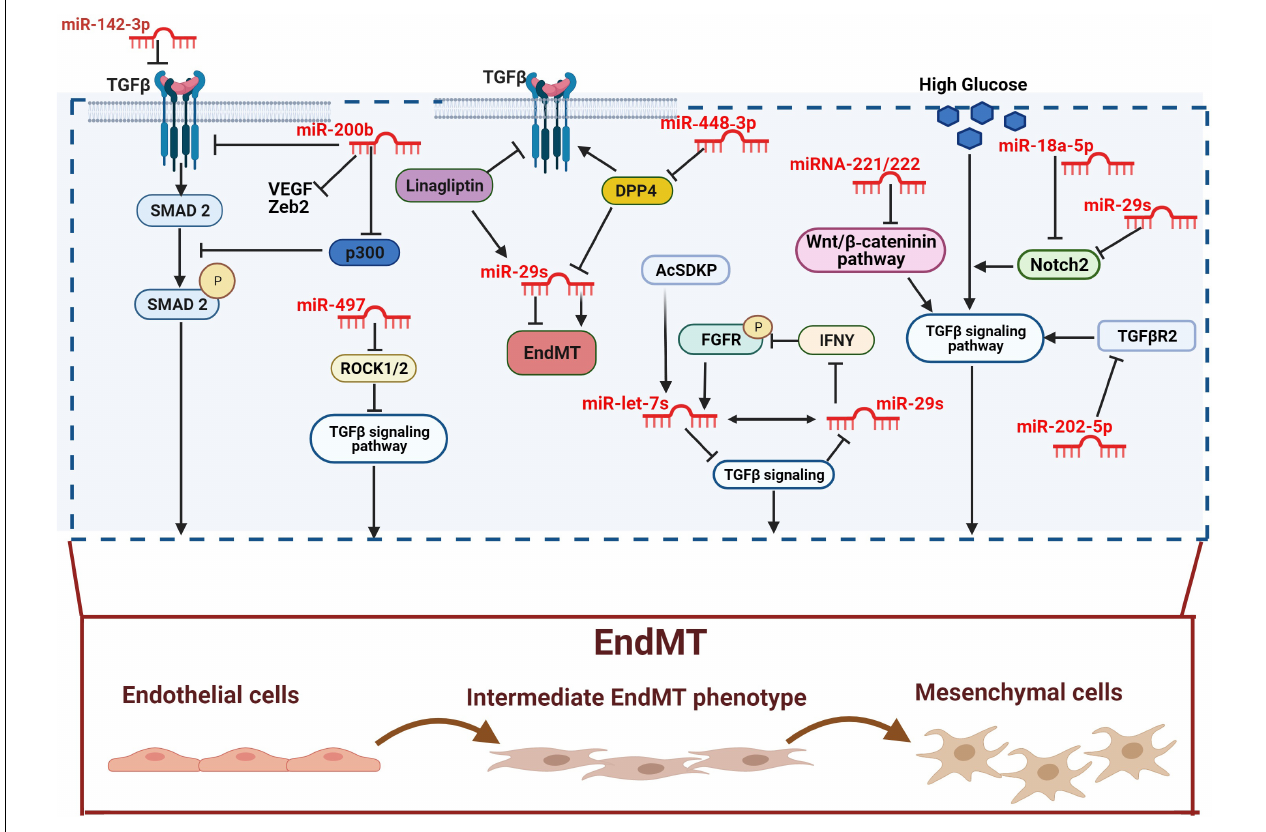
FIGURE 1 | Anti-fibrotic miRNAs in diabetic complications. miR-142-3p and miR-200b inhibit EndMT by inactivating the TGF- β -SMAD pathway. The antifibrotic activity of miR-200b is played by down-regulating the TGF- β /SMAD pathway coactivator p300. miR-497 suppresses TGF- β -induced EndMT by ROCK1 and ROCK2 inactivation. The overexpression of DPP-4 is associated with the suppression of the miR-29s family anti-fibrotic activity. However, both linagliptin and AcSDKP suppresses EndMT by restoring miR-29 and miR-let-7s activities. Furthermore, miR-448-3p inhibits EndMT via DPP-4 suppression. AcSDKP upregulates the antifibrotic miR-let-7 which suppresses TGF β R1 and TGF β signaling. The block of TGF β signaling results in up-regulation of miR-29 gene expression, which in turn causes FGFR1 phosphorylation. FGFR1 phosphorylation is critical for miR-let-7 production. miR-29 can also target the profibrotic IFNY blocking its inhibitory action toward FGFR1. The miR-29s family inhibits high glucose-induced EndMT by down-regulating Notch2, which is also suppressed by miR-18a-5p. However, DPP-4 inhibitor and AcSDKP suppresses EndMT by restoring of miR-29 and miR-let-7s activities. Furthermore, miR-448-3p inhibit EndMT via DPP-4 suppression. The miR-29s family inhibits high glucose-induced EndMT by the downregulation of Notch2 which is also suppressed by miR-18a-5p. High glucose-induced EndMT is also suppressed by miR-221/222 family, via the negative regulation of Wnt/ β -catenin, and by miR-202-5p via inhibition of TGF β R2/TGF β signaling pathway. Pro-fibrotic miRNAs are showed in dark, anti-fibrotic miRNAs in red.